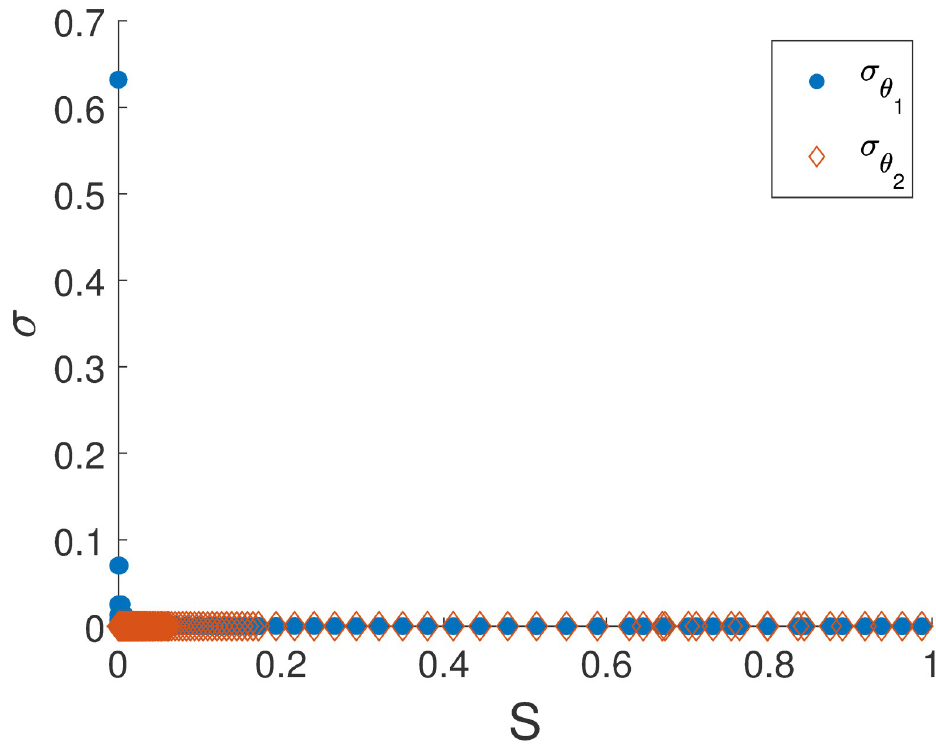
Fig 4. Standard errors of the parameter estimates obtained from various initial conditions (Fig 3b) plotted against the corresponding sloppiness value. It is seen that there is no specific relationship between sloppiness and standard